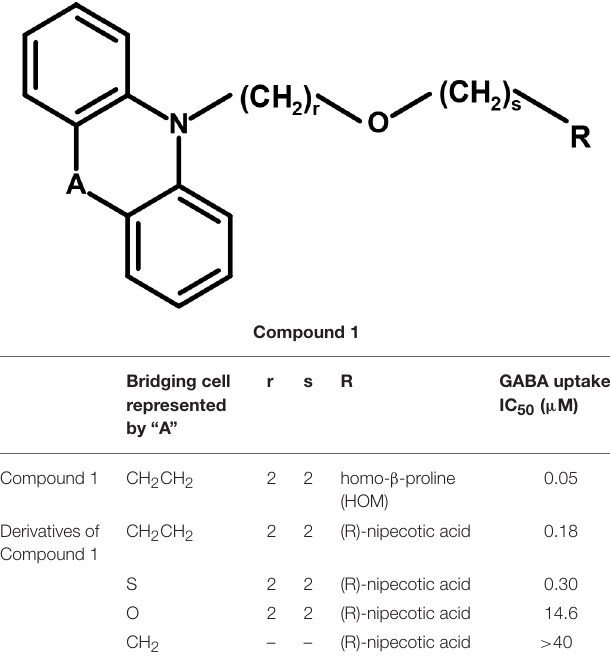
TABLE 2 | Derivatives of Compound 1 as modulators of hGAT1.